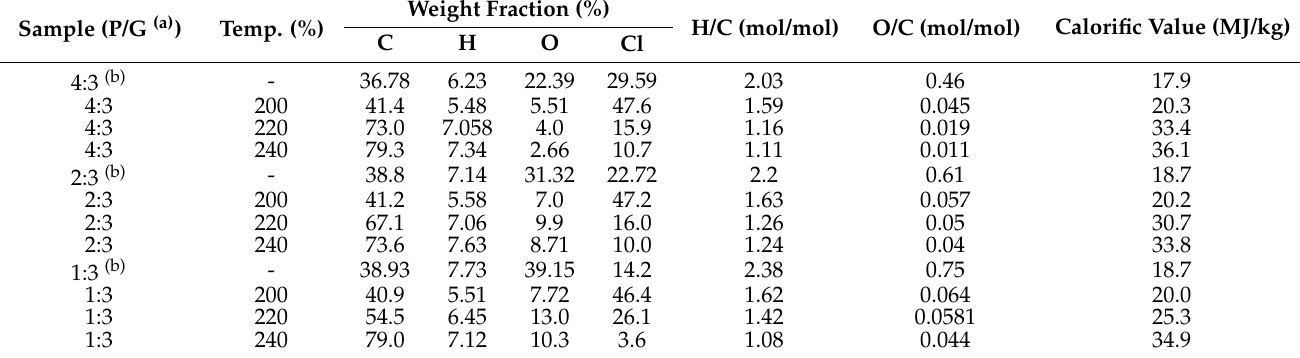
Table 4. Elemental analysis and calorific value for PVC-P solid products.